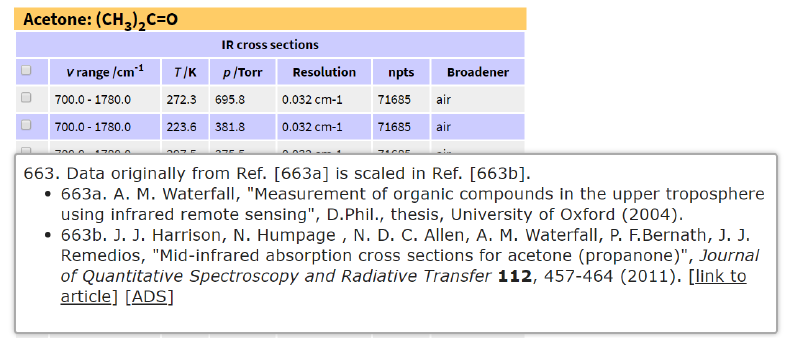
Figure 1. The bibliography for a given temperature-pressure ( T-p ) absorption cross section of acetone. In this example, the cursor is over the second entry of the table. The number 663 to the left of the bibliography is the corresponding “global” ID integer, and the two links at the end will take the user to the full-text article on the publisher’s website or ADS, respectively. There are two references displayed in this bibliography for one line of data; these two are labeled separately 663a and 663b.